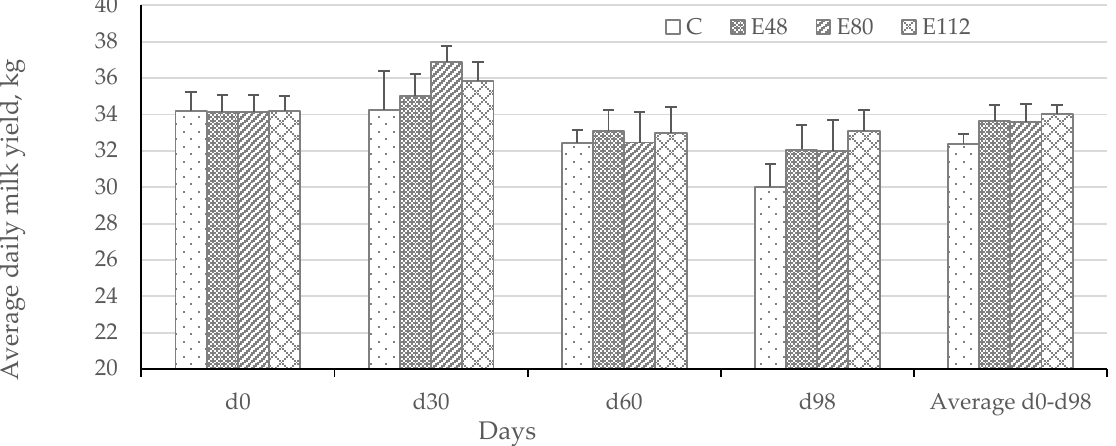
Figure 8. Milk yield of cows ( n = 12) of natural fat, kg. No significant differences in fat and protein content were found in studies of milk composition and quality (Table 8). Table 8. Dairy productivity and milk quality parameters during the experiment (average per